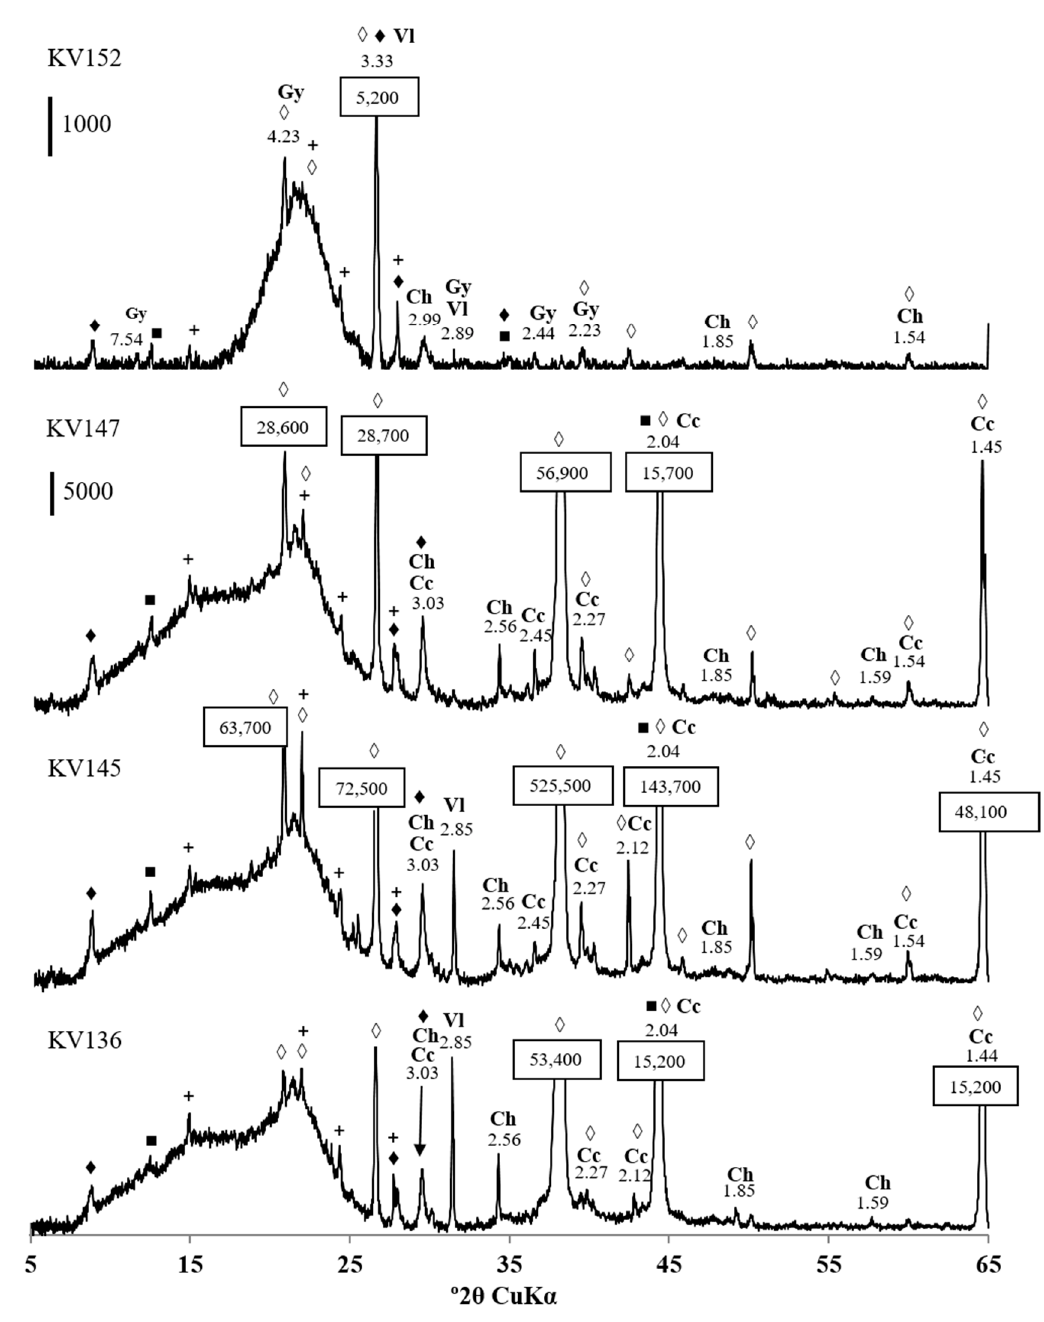
Figure 1. X-ray diffraction patterns of fecal samples KV152, KV147, KV145, and KV136. Letter codes: Ch = chalcopyrite, CuFeS 2 ; Vl = villamaninite, CuS 2 ; Gy = gypsum, CaSO 4 ; Cc = calcite, CaCO 3 . The diagnostic peaks for muscovite ( ♦ ), clinochlore ( ■ ), quartz ( ◊ ), and albite (+) are indicated. The vertical bar shows the scale of relative counts.